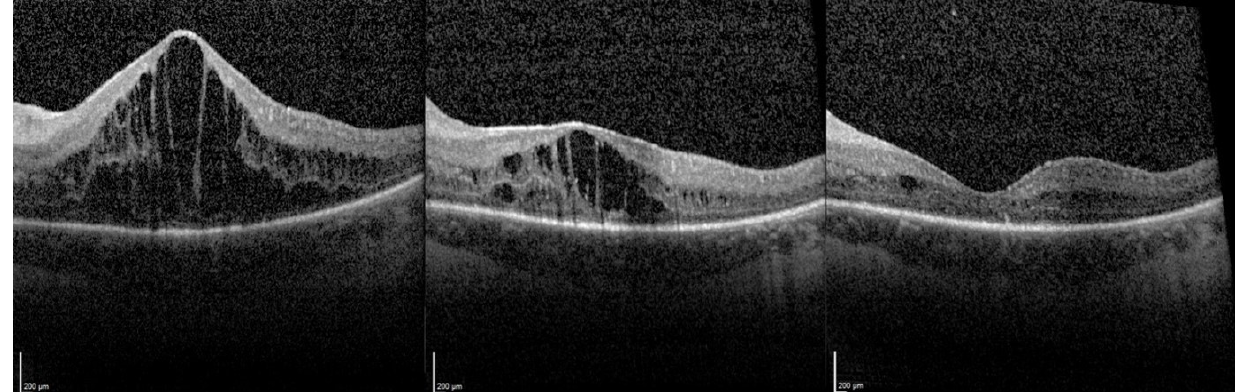
Figure 4. Optical coherence tomography of severe macular edema pre FAc, 3 months after FAc, and 12 months after FAc and additional single injection of Ozurdex and multiple triamcinolone injections to dry the macula.